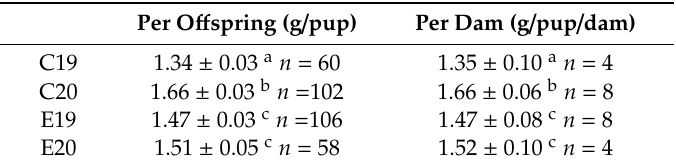
Table 1. Mean ± 95% confidence interval birth weights for the control (C) and experimental (E) o ff spring born on day 19 (C19 and E19) and 20 (C20 and